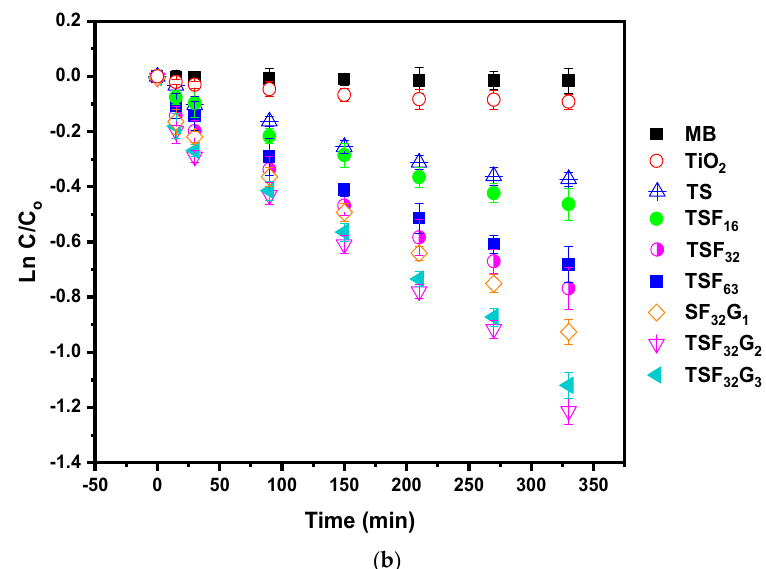
Figure 7. The photocatalytic activity for degradation of MB under ( a ) UV and ( b ) UV-Vis lights for TiO 2 , TS, TSF, and TSF 32 G coated films. Table 2. Kinetic constants of photocatalytic MB degradation under UV and vis lights for TiO 2 , TS, TSF, and TSF 32 G coated films, plus degradation extent after 330 min test.